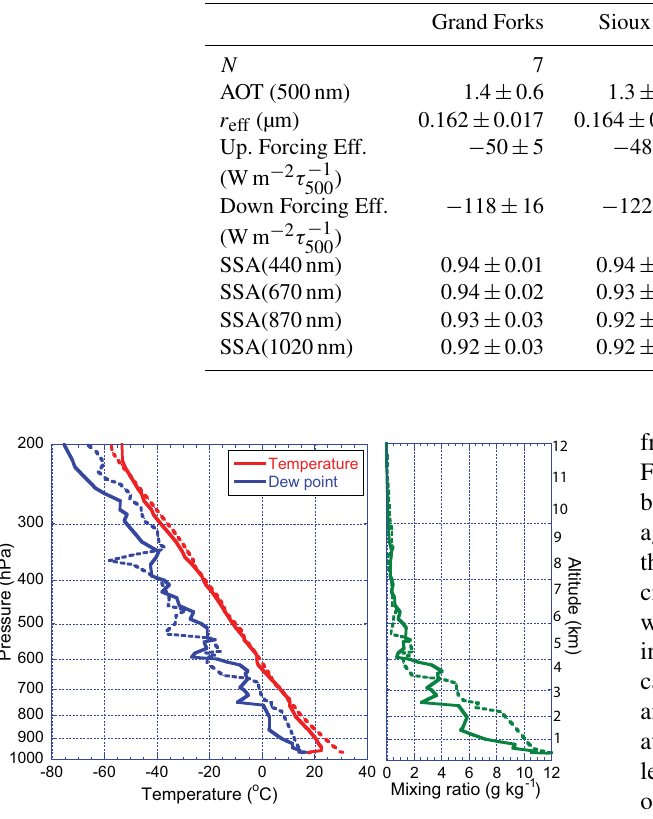
Figure 3a, c, and e show the RGB true color images of the smoke event over the upper Midwestern United States on 28 June (17:00 and 17:05 UTC) and 29 June (17:45 UTC), and over the Upper Mississippi and Ohio River Valley on 30 June (16:50 and 16:55 UTC), constructed using the Col- lection 6, Level 1b Terra MODIS data. Figure 3b, d, and f show the corresponding Terra MODIS C6 DT τ 550 for the same study periods as Fig. 3a, c, and e. The observed surface temperatures reported from ASOS stations are overplotted on Fig. 3a, c, and e from North Dakota, South Dakota, Ne- braska, Minnesota, and Iowa on 28 and 29 June, and from Al-